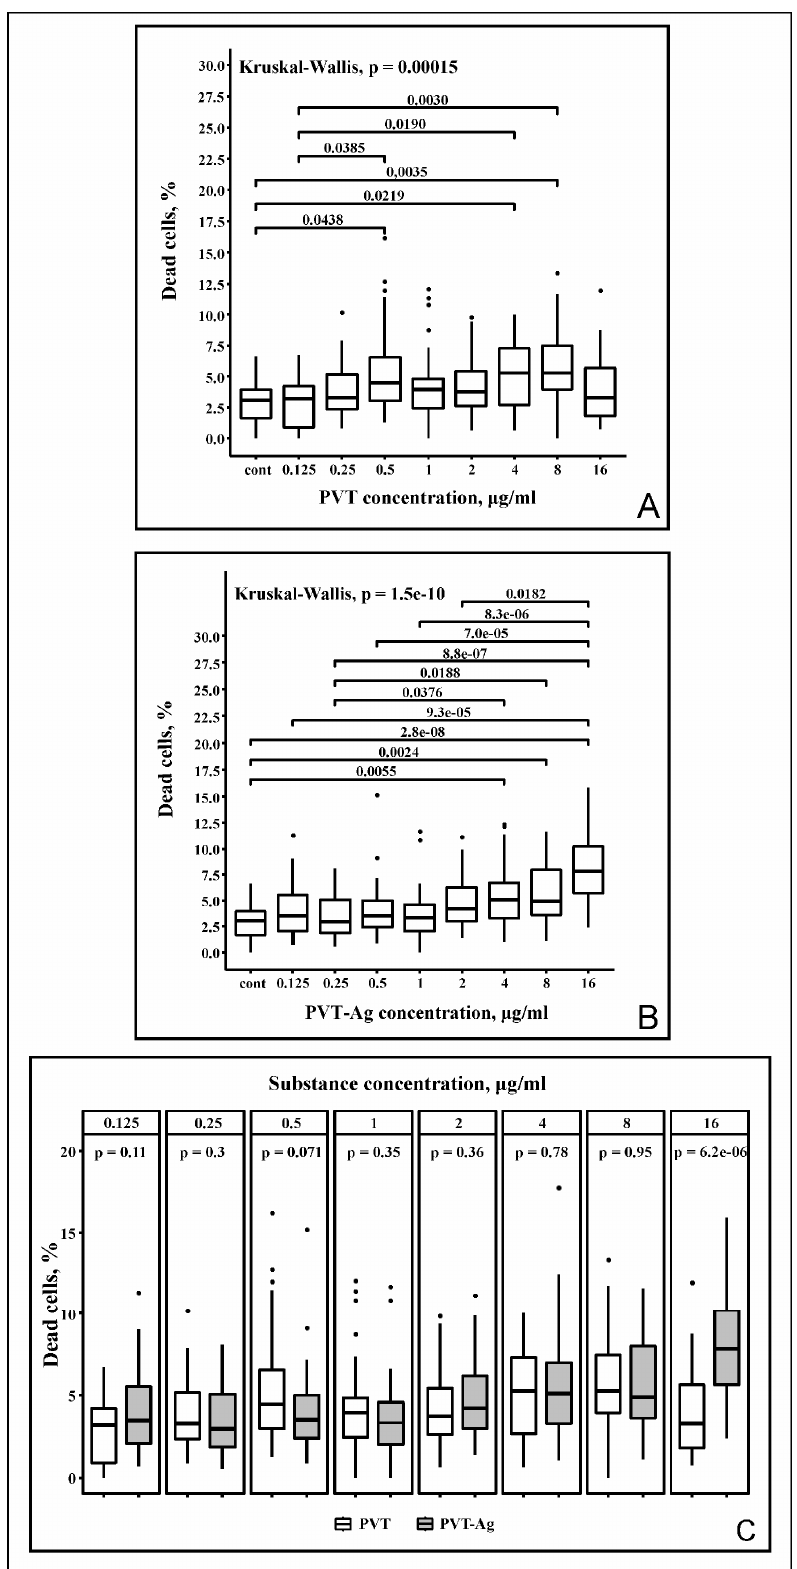
Figure 8. Analysis of the number of dead fibroblasts after incubation for 24 h with ( A ) PVT, ( B ) Ag(0)-PVT in the different concentrations and ( C ) in comparison to each other.. Medians, first and third quartiles are presented; p -values are given only for significant differences ( p < 0.05).